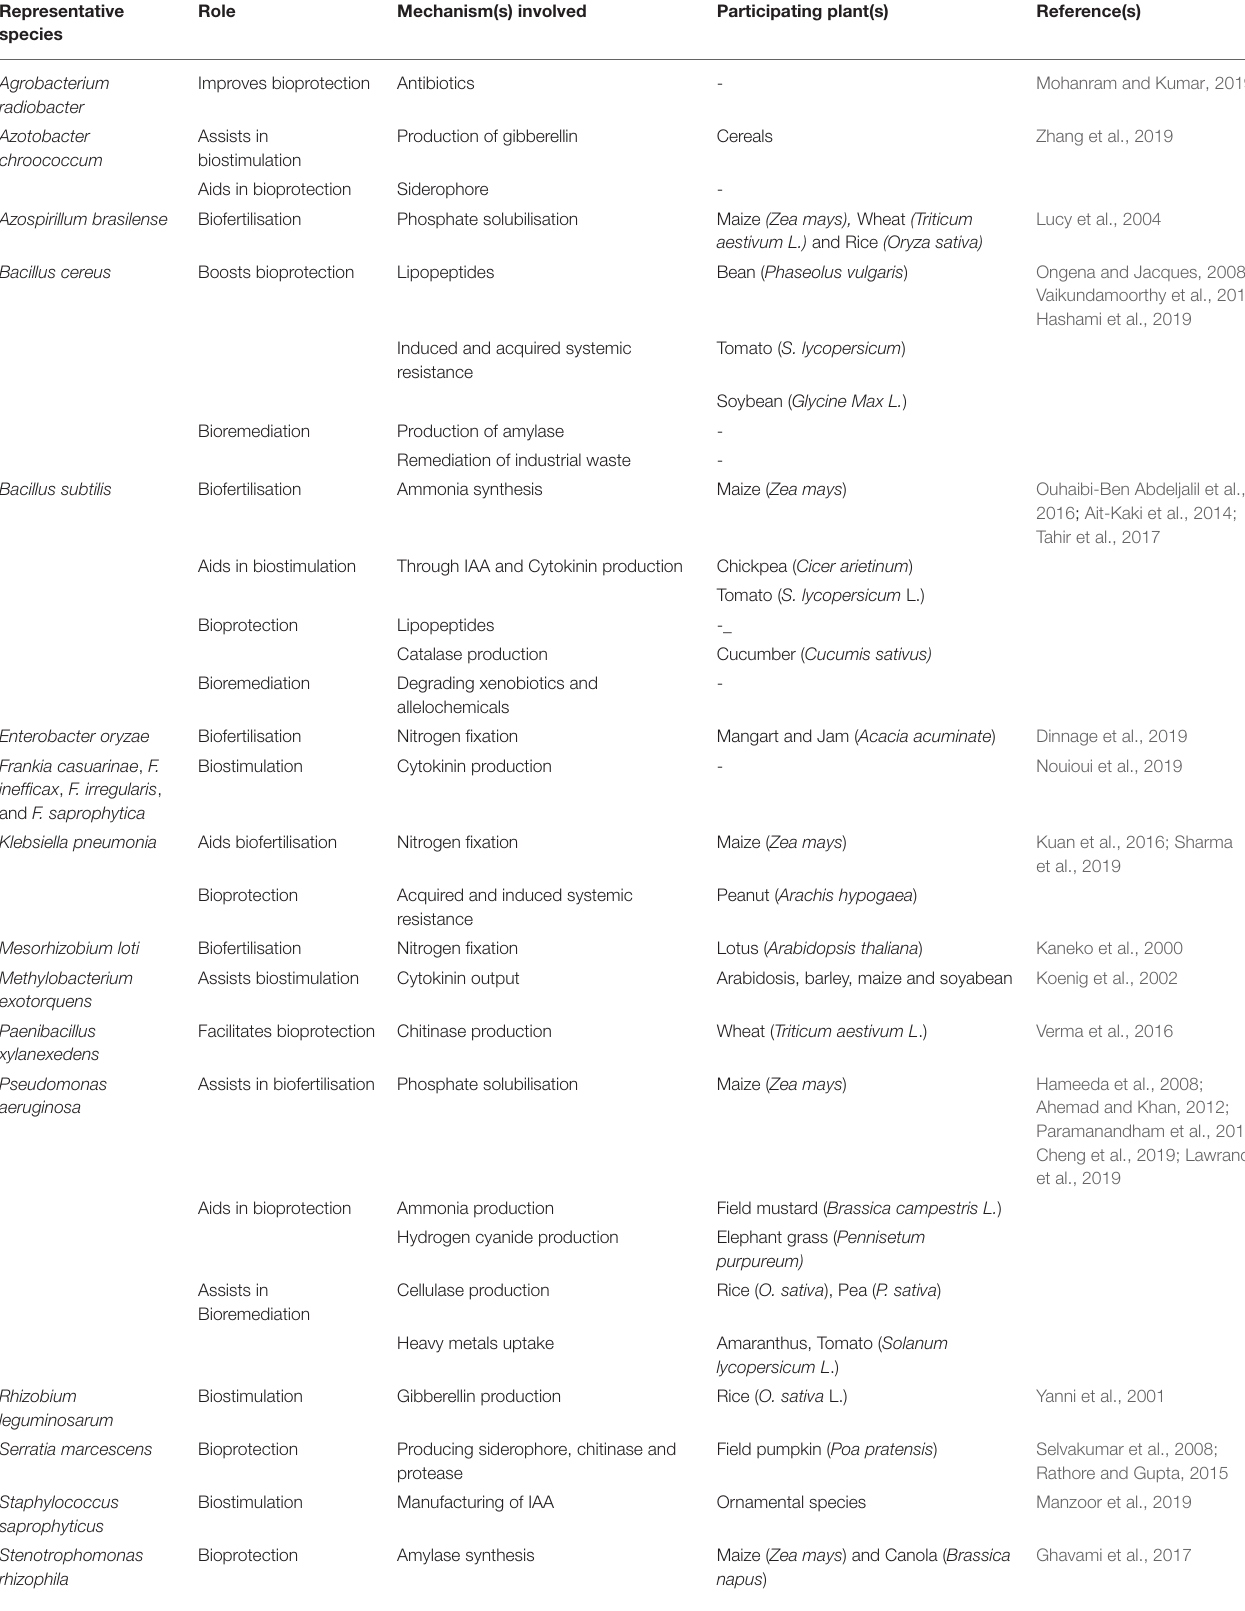
TABLE 1 | The role of some select PGPR candidates in the rhizosphere. Representative